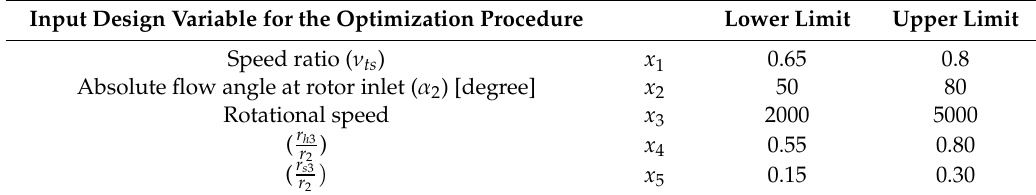
Table 2. List of the design variables with the upper and lower